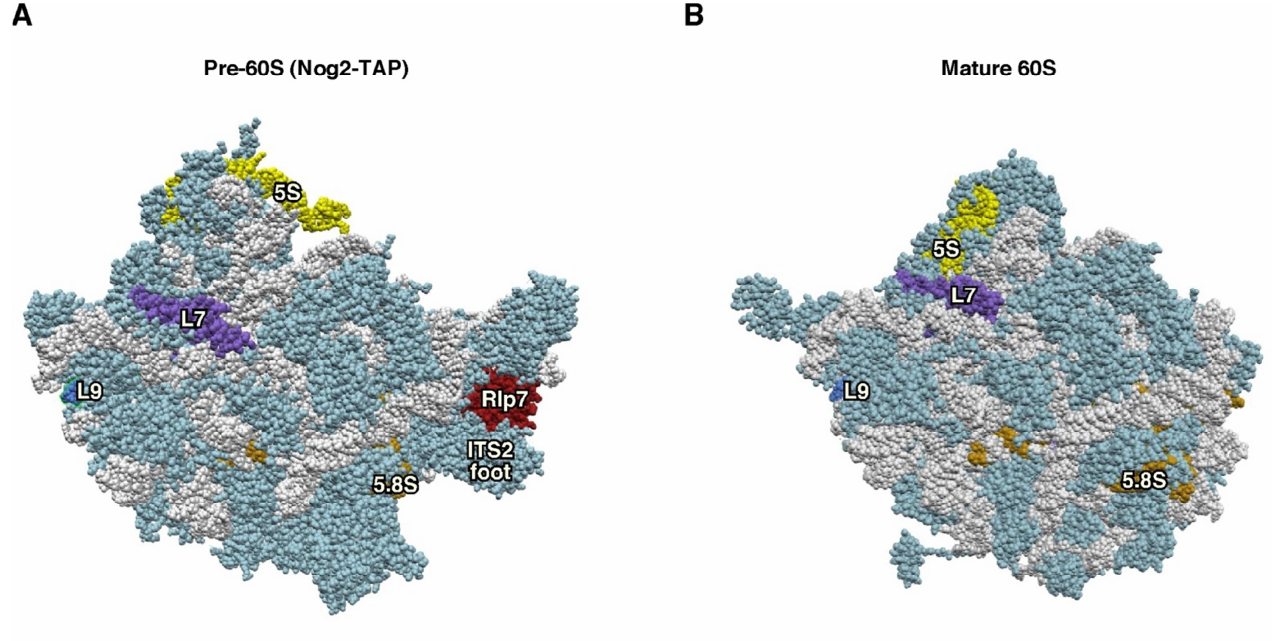
Figure 3: Rlp7 is not the placeholder factor for the assembly of L7 r-protein. (A) Position of Rlp7 (red) and L7 (purple) in the early pre-60S r- particles purified with Nog2-TAP (PDB ID: 3JCT; [40]). (B) Position of L7 r-protein (purple) in the mature 60S r-subunit (PDB ID: 3U5I, 3U5H; [44]). Particles are viewed from the solvent side. For orientation, the positions of the 5S rRNA (yellow), 5.8S rRNA (gold) and the L9 r-protein (royal blue) have been highlighted. The ITS2 foot has also labelled in A. Note that L7 is found at its final assembly position within Nog2-TAP pre-60S r- particles. The first ca. 20 amino acids of both proteins could not be modelled in either structure. The rest of rRNAs are coloured in pale blue and the rest of r-proteins and/or factors in light cornflower